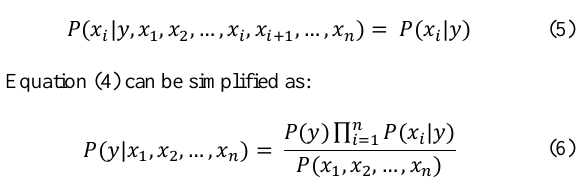
Figure 3. The geography of Toronto, Ontario, Canada Table 2. A sample of association rules